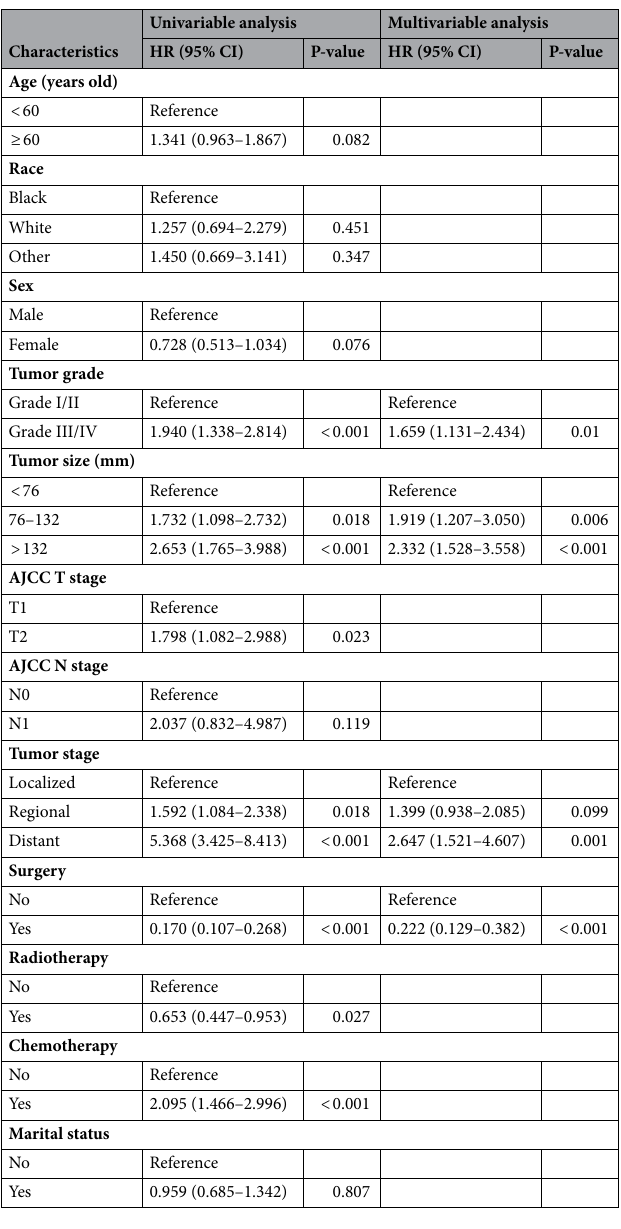
Table 2. The univariable and multivariable Cox regression analyses of patients with retroperitoneal leiomyosarcoma in this cohort retrospective study. HR: hazard ratio; CI: confidence interval; AJCC: American Joint Committee on